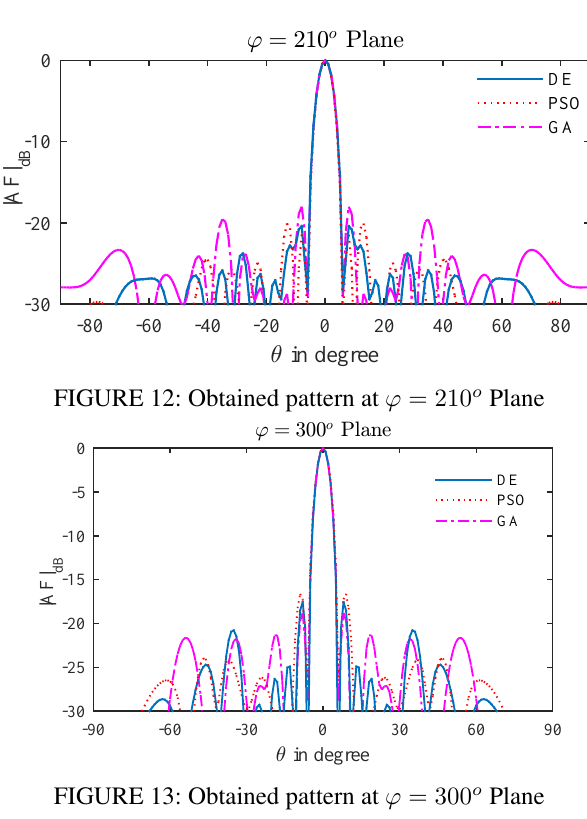
FIGURE 13: Obtained pattern at ϕ = 300 o